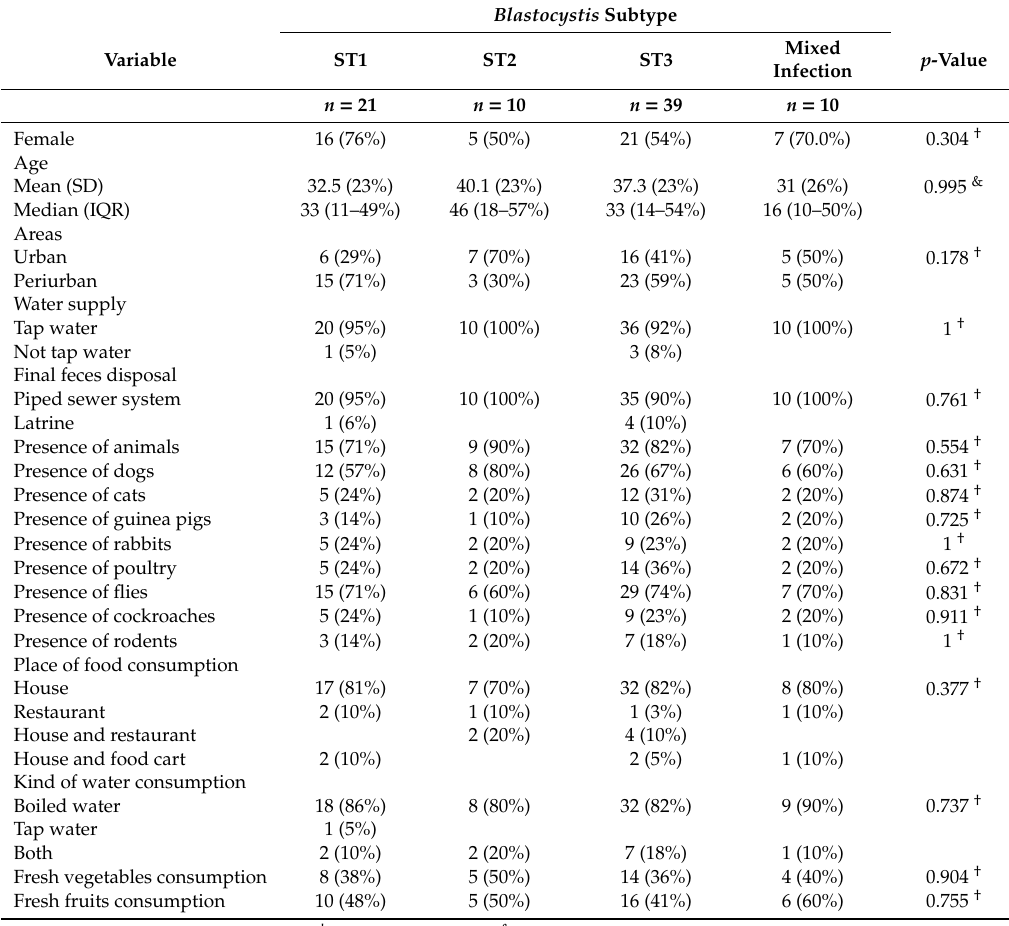
Figure 4. Symptomatology percentage by Blastocystis subtypes 1, 2, 3, and mixed infection. Table 2. Relationship between Blastocystis subtypes and sanitary living